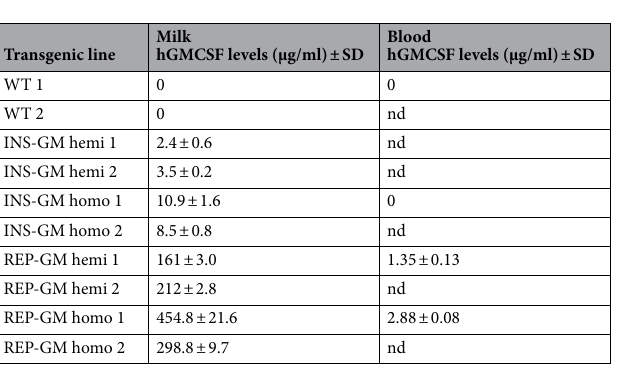
Table 1. ELISA quantification of the hGMCSF in the milk and blood of transgenic female mice.